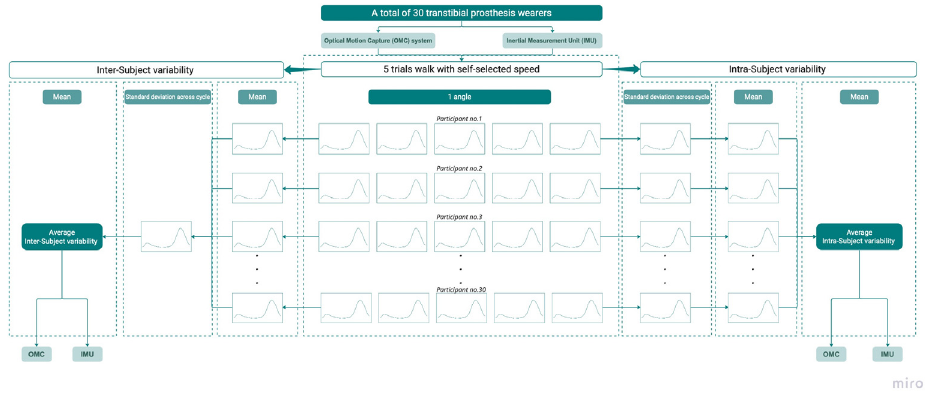
Figure 4. Procedure of data processing [26] for averaged intra-subject variability and average inter-subject variability across the gait cycle.